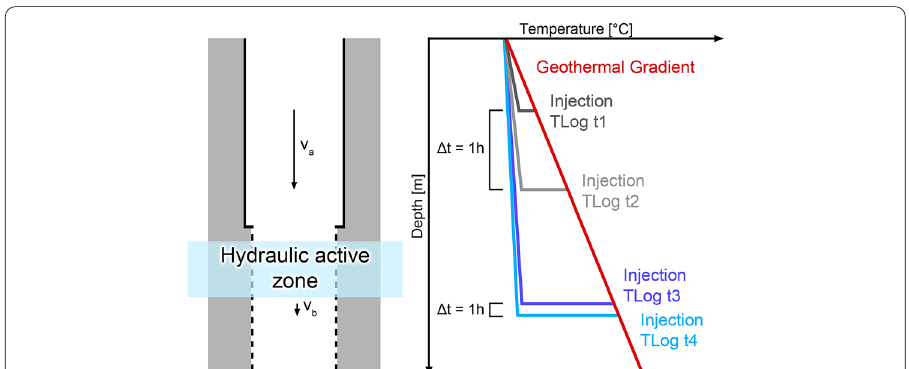
Fig. 5 Schematic DTS velocity track analysis during injection of cold water. Dark gray and light gray lines are DTS temperature logs (TLog) at different times t1 and t2 and show the downhole propagation of injected cold water in the cased section of a well. Dark blue and light blue lines are DTS profiles at later times t3 and t4 below a feed zone. v a and v b are the velocities above and below the hydraulic active